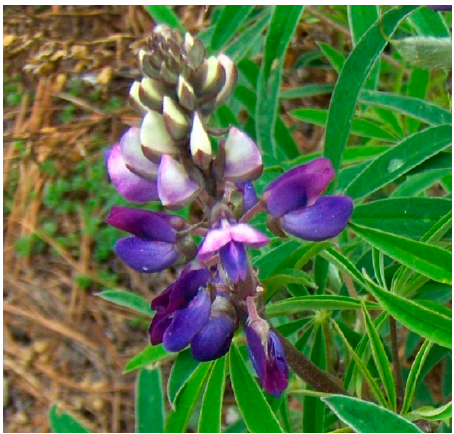
Figure 8. Lupinus rotundiflorus M.E. Jones. Photo: M. Ruiz.